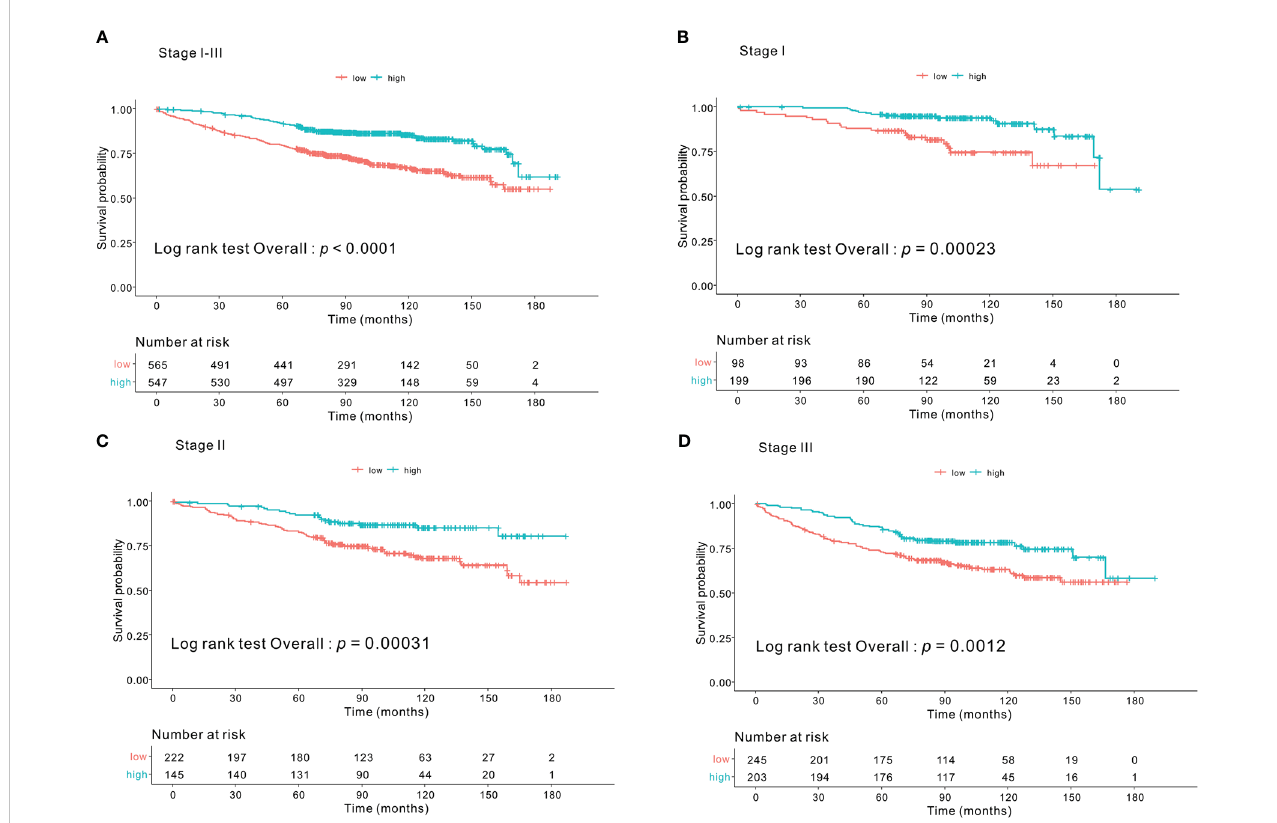
FIGURE 2 The 5-year OS rates of patients in the high- and low- PNI groups were 91.7% and 79.3% ( p < 0.0001) (A) , respectively. In tumor stage I subgroup, they were 96.4% and 86.7% ( p = 0.001) (B) ; stage II subgroup, 92.3% and 82.6% ( p = 0.001) (C) ; and stage III subgroup, 86.2% and 72.8% ( p = 0.001) (D) , respectively. OS, overall survival; PNI, prognostic nutritional